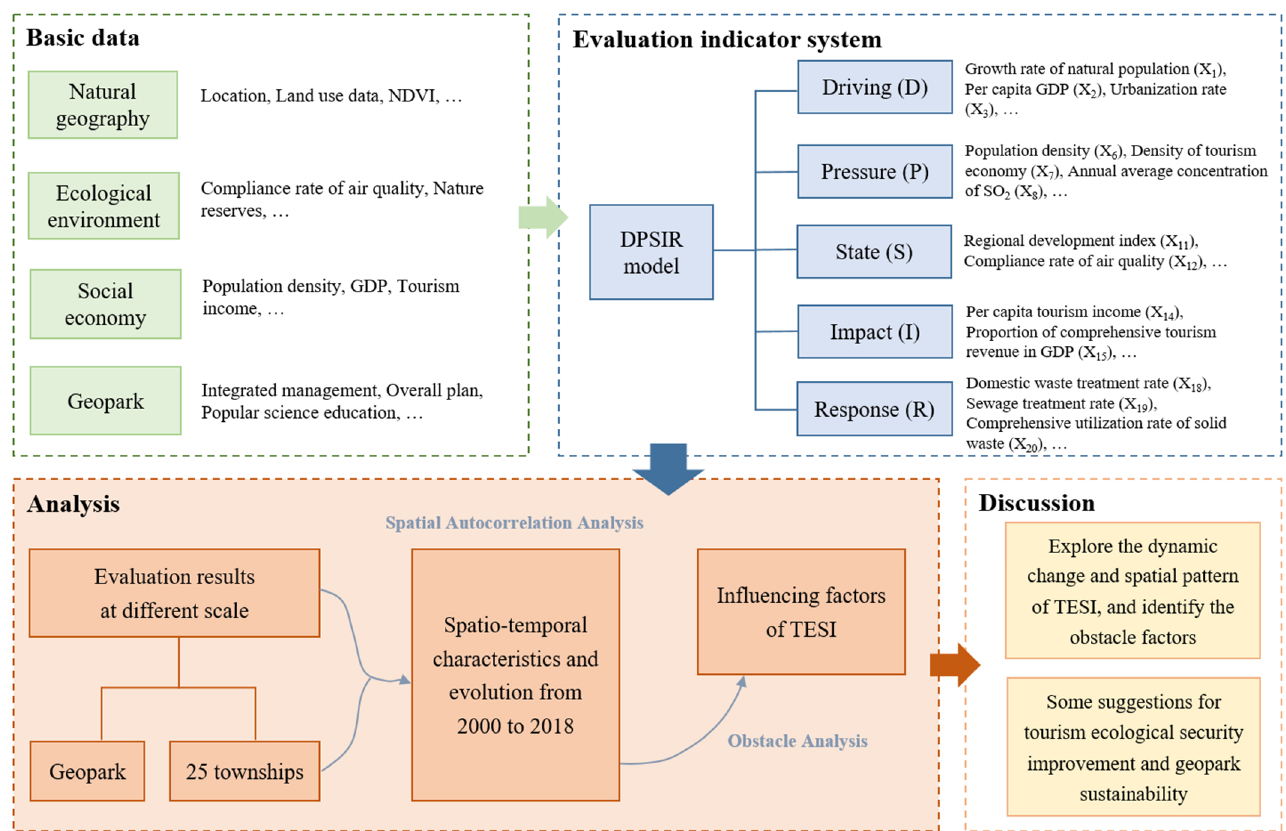
Figure 1. The framework of tourism ecological security evaluation of Huanggang Dabieshan UGGp.